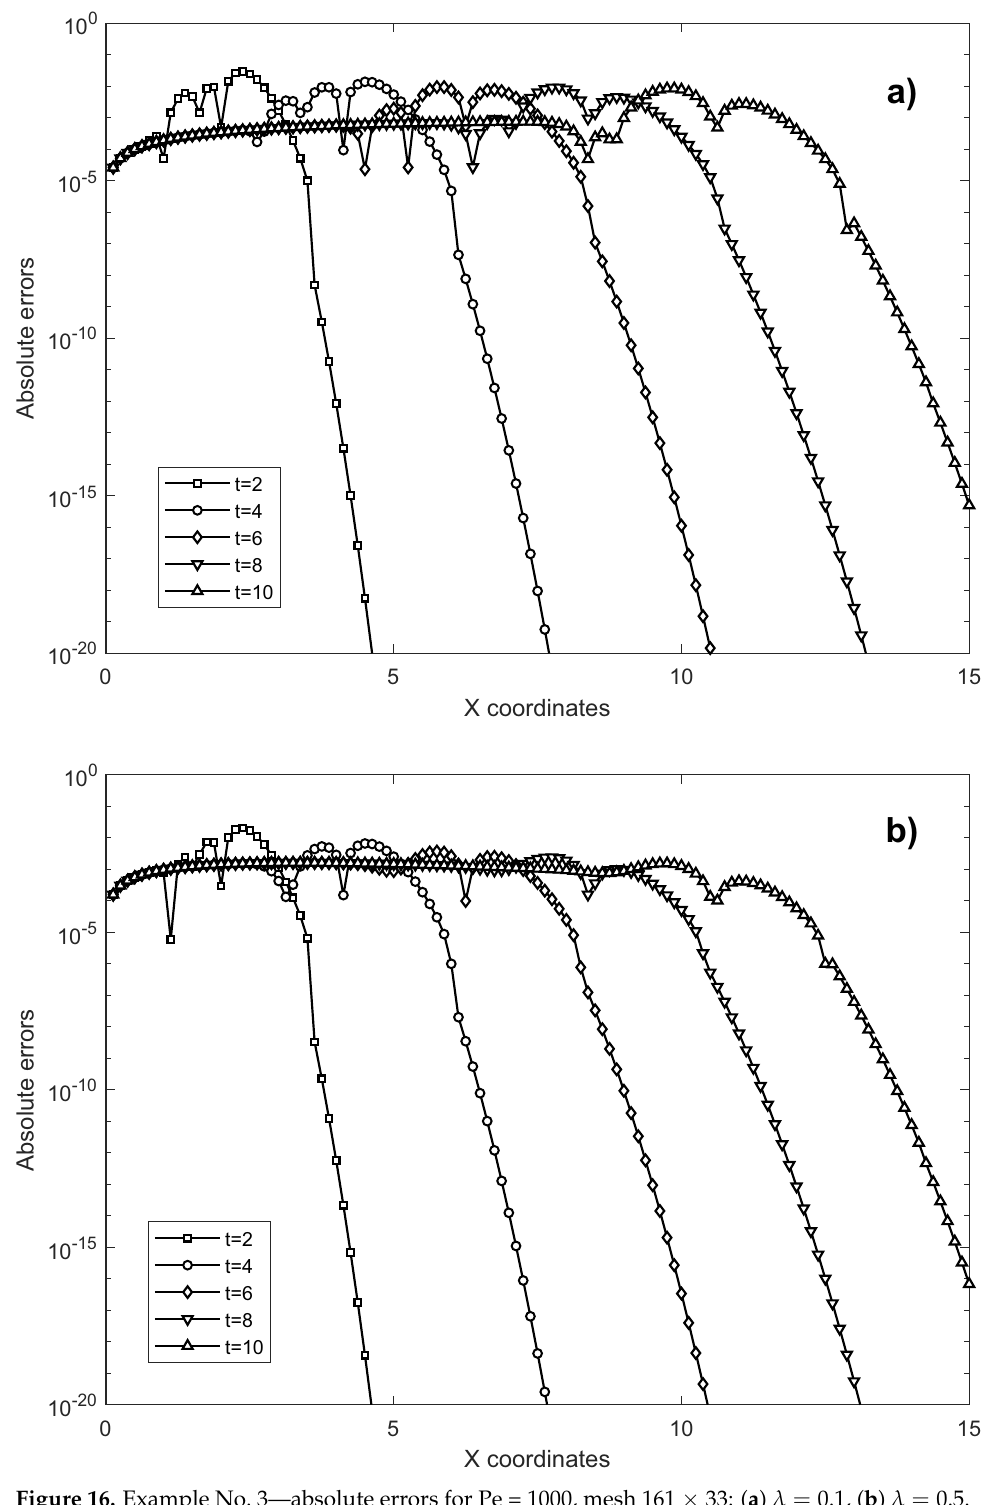
Figure 16. Example No. 3—absolute errors for Pe = 1000, mesh 161 × 33: ( a ) λ = 0.1, ( b ) λ =